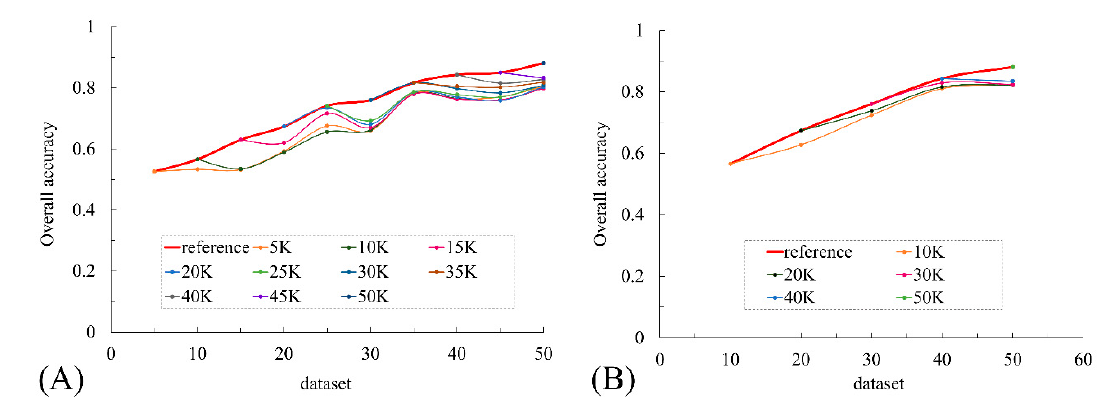
Figure 6. Relation between datasets and overall accuracy for manual training. ( A ) Additional learning for every 5000 images, ( B ) additional learning for every 10,000 images.